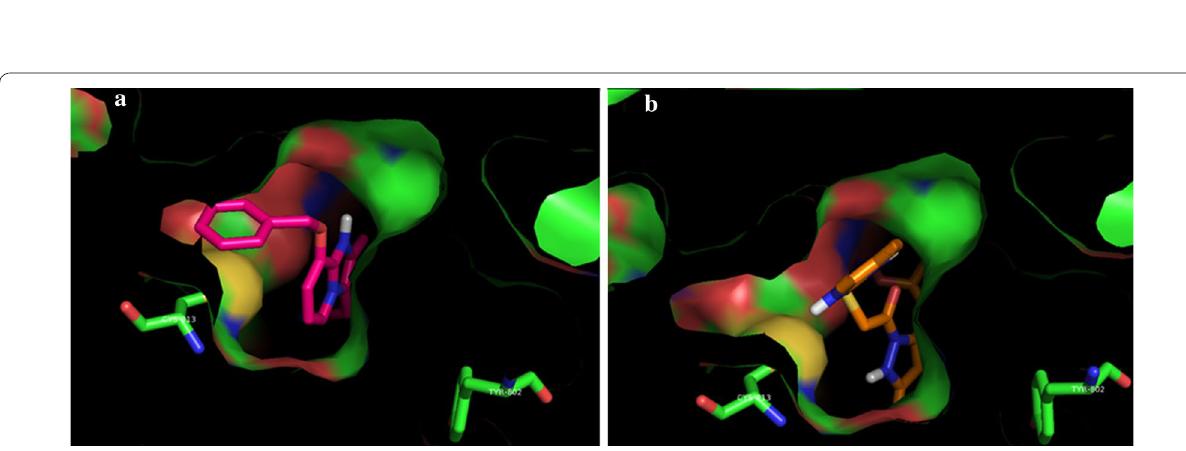
any mortality up to dose of 100 mg/kg. 5f was found lethal at the dose of 100 mg/kg.